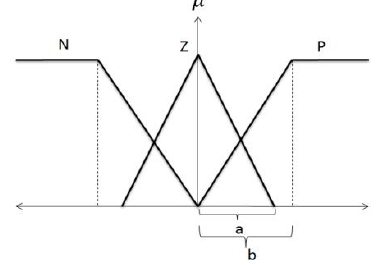
Figure 7. Parameters defined for fuzzy membership functions.